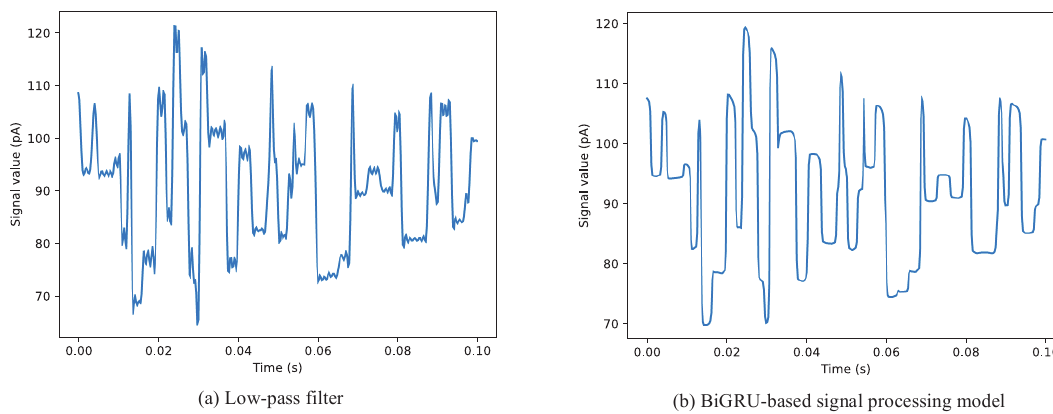
Figure 7. Waveform comparison of two filtered signals from different signal processing methods: ( a ) the filtered signal output by low-pass filter; and ( b ) the filtered signal output by BiGRU-based signal processing model. Compared with low-pass filter, BiGRU-based signal processing model only processes the signal at the 6-mer change, which is more